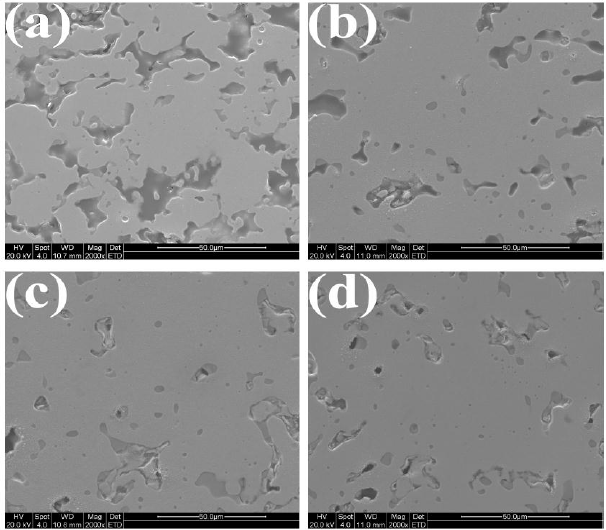
Figure 9. Morphology of the MM Fe-Mn-Si compacts sintered at 1200 °C for various isothermal holding times: ( a ) no isothermal holding; ( b ) 1 h; ( c ) 2 h; ( d ) 3 h.